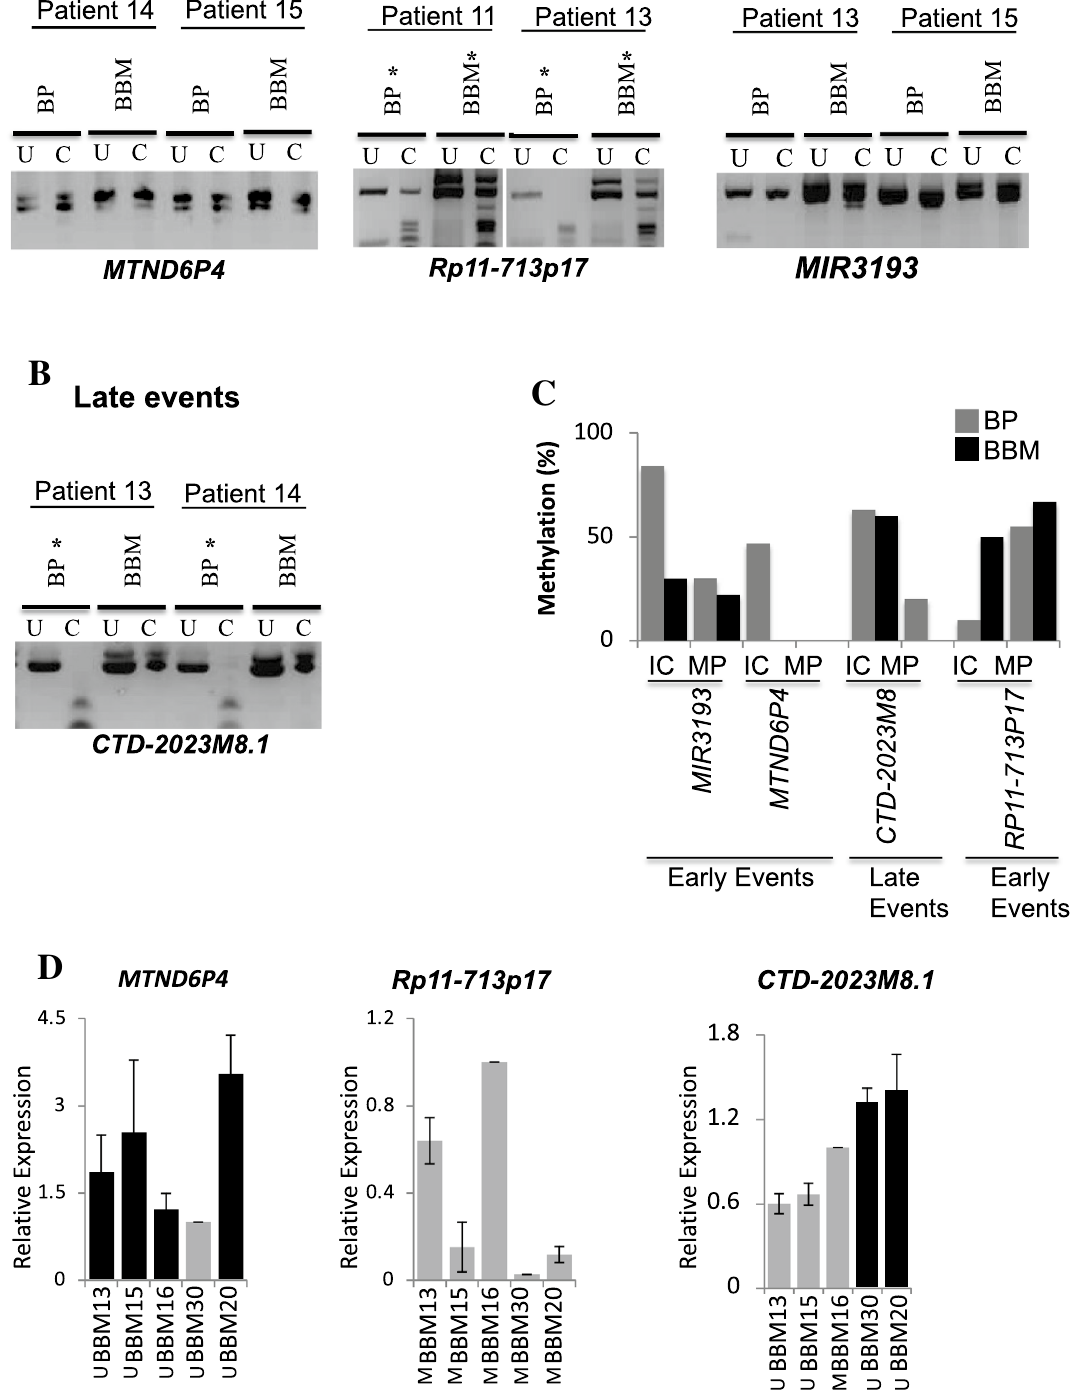
Figure 3. Methylation status of BBM-Hypermethylated and BBM-Hypomethylated genes in BBM and their originating BP tumours from individual patients. ( A ) Early events ; Methylation of MTND6P4 (left panel), RP11-713P14.4 (middle panel) and MIR3193 (right panel) in originating BP is the same as found in their corresponding BBM in individual patients ( B ) Late events ; Methylation status of CTD-2023M8.1 in orginating BP is different to their corresponding BBM tumours (loss of methylation at this region occurs in the metastasis). ( C ) Summary of methylation status of genes denoting early events and late events in individual patients/matched pairs (MP) and an independent cohort (IC) of primary breast tumours. ( D ) Expression analyses of genes by quantative reverse transcriptase PCR (qRT-PCR) in representative BBM tumours showing methylation-expression correlation, tumours with genes that are methylated (M) have a low level of expression. BP: Breast Primary tumour, BBM: Brain Metastases, U: Uncut/Control sample, C: cut by methylation specific restriction enzyme, *: Methylated samples, IC: independent cohort, MP: matched pairs from individual